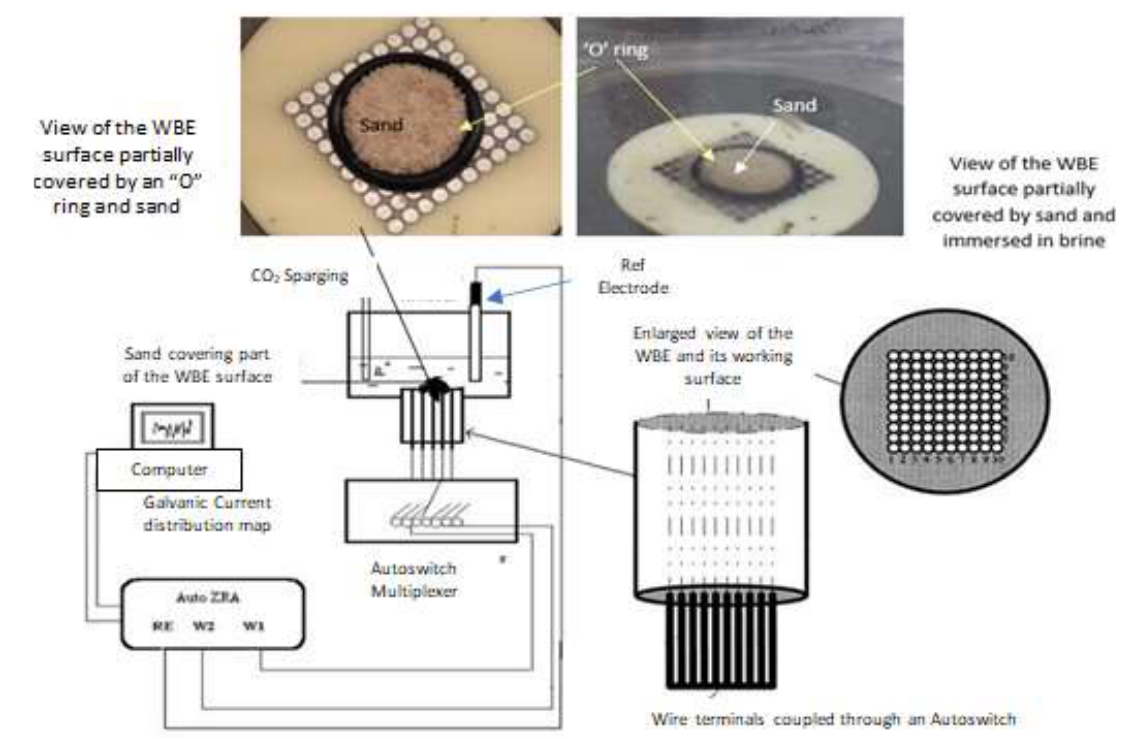
Figure 5. Schematic diagrams showing a WBE test setup for under-deposit corrosion and its inhibi- tion [87] . Reproduced with permission.